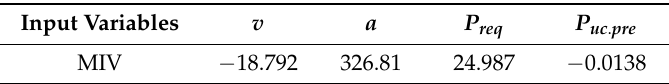
Table 5. Mean impact value (MIV) of each characteristic